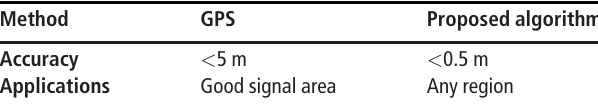
Table 3 Comparison of vehicle location methods